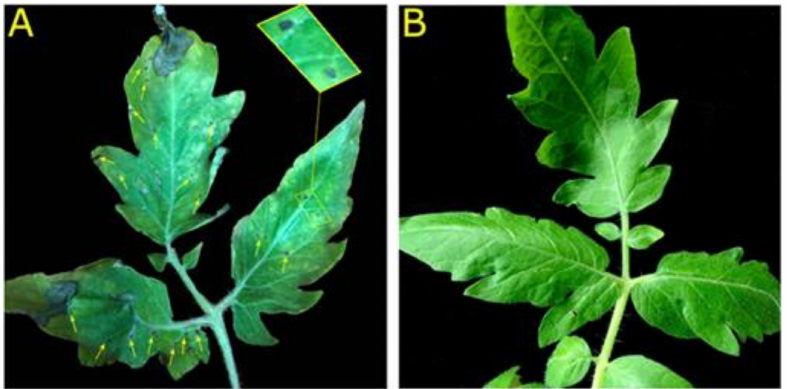
Figure 6. Leaf spot disease on S. lycopersicum prevented by ZM-804 peptide. Bacterial cells of P. syringae pv. tomato DC3000 ( ∼ 10 6 CFU/mL) were treated with 4 µ M ZM-804, while the control was treated with dd water (without peptide). In each treatment, 10 mL was sprayed directly on tomato plant leaves until both adaxial and abaxial surfaces were uniformly wet using a sprayer. Six days after inoculation, the symptoms of leaf spot disease were observed on the leaves surface of the control; yellow arrows indicate the spots in the control ( A ), while the treatment with ZM-804 prevents leaf spot of tomato caused by P. syringae pv. tomato DC3000 ( B ).